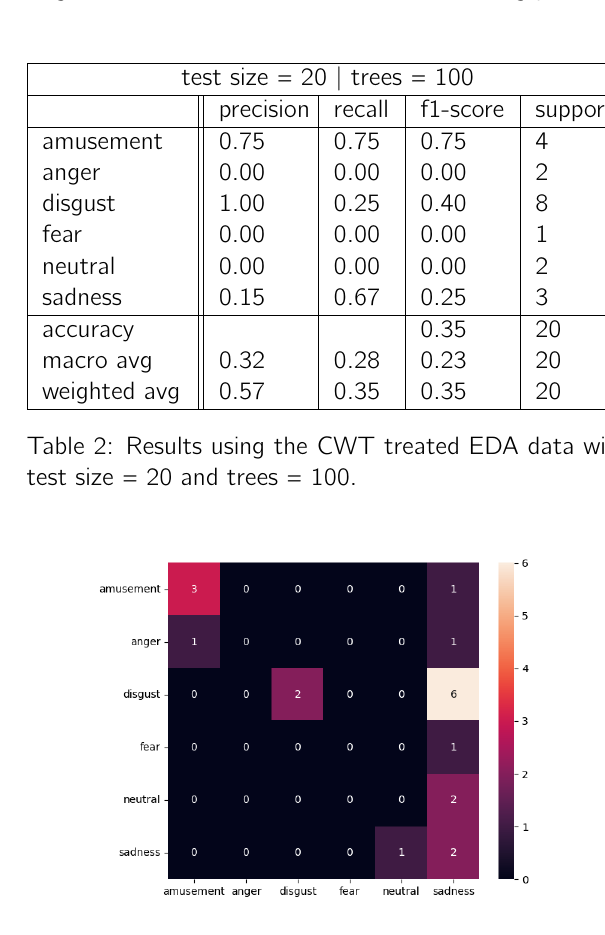
Figure 4: Architecture of the machine learning process.